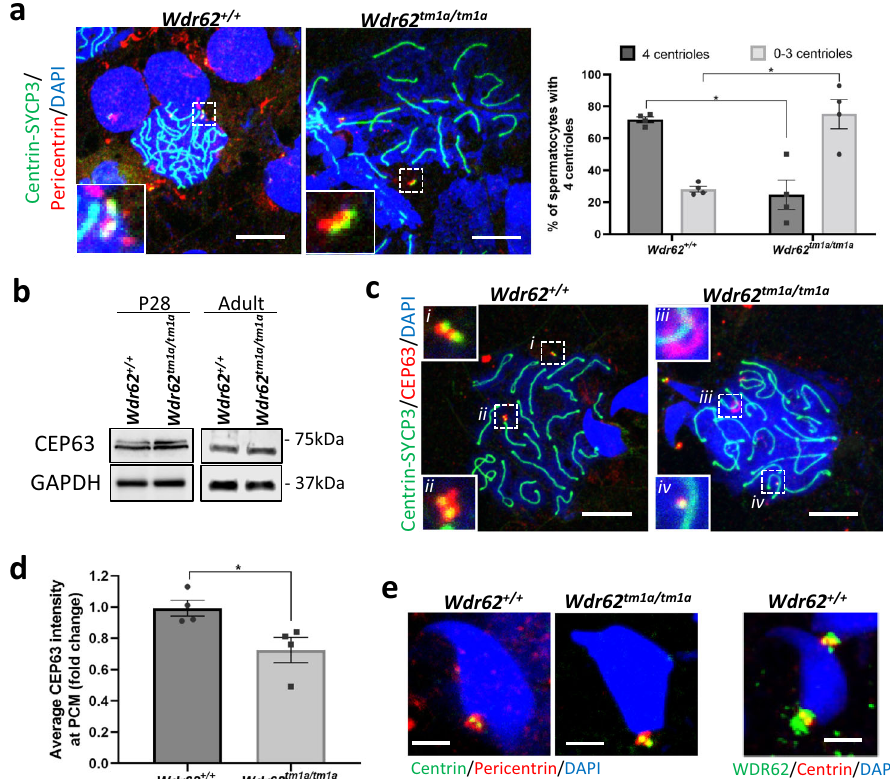
Fig. 4 Wdr62 tm1a/tm1a spermatocytes exhibit centriole underduplication during meiosis. a Centrin-SYCP3 (green) and Pericentrin (red) co- immuno fl uorescence on spermatocyte spreads from adult testis. Negative IgG control is shown in Supplementary Fig. 7d. The number of centrioles was quanti fi ed in pachytene and diplotene spermatocytes and graphed as % of total spermatocytes counted. In Wdr62 + / + spermatocytes, approximately 70% show four centrioles; however, this percentage is reduced to 25% in Wdr62 tm1a/tm1a spermatocytes, suggesting centriole underduplication. Scale bar represents 10 μ m. n = 157 spermatocytes from fi ve independent Wdr62 + / + and 172 spermatocytes from six independent Wdr62 tm1a/tm1a testis. Two-tailed Student ’ s t -test. * p = 0.0329. b CEP63 western blot of P28 and adult Wdr62 + / + and Wdr62 tm1a/tm1a testis. GAPDH is used as loading control. See Supplementary Fig. 6 for western blots and band quanti fi cation. c Centrin-SYCP3 (green) and CEP63 (red) co-immuno fl uorescence on spermatocyte spreads from adult testis. Scale bar represents 10 μ m. Negative IgG controls are shown in Supplementary Fig. 7e. d CEP63 intensities from c are quanti fi ed, showing approximately 20% reduction in CEP63 accumulation at the PCM in Wdr62 tm1a/tm1a spermatocytes. n = 29 Wdr62 + / + and 26 Wdr62 tm1a/tm1a pachytene and/or diplotene spermatocytes from three independent testis per genotype. Error bars represent SEM in a and d . Two-tailed unpaired Student ’ s t -test, * p = 0.0305. e [Left] Pericentrin (red) and Centrin (green) co-staining of adult Wdr62 + / + and Wdr62 tm1a/tm1a spermatocyte spreads. [Right] WDR62 (green) and Centrin (Red) co-immuno fl uorescence of adult Wdr62 + / + spermatocyte spreads. A pair of centrioles is localised to the